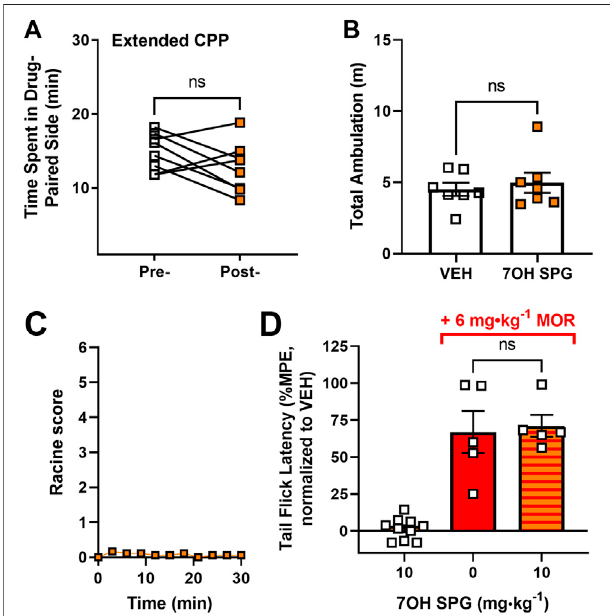
FIGURE7| Sideeffect pro fi le of10mg · kg ⁻ 1 7-hydroxyspeciogynine. (A) In a 10-day conditioned place preference (CPP) paradigm, the rewarding effects of 7-hydroxyspeciogynine (s.c.) were evaluated in male, WT mice ( n (cid:2) 8). (B) Locomotor data were extracted from the CPP experiment in (A) and averaged across all vehicle/ drug treatment days ( n (cid:2) 7). (C) The highest Racine score collected every 3 min for 30 min following administration of 7-hydroxyspeciogynine was evaluated for 30 min after drug administration ( n (cid:2) 9). (D) 7-hydroxyspeciogynine was tested for agonist and analgesic properties in male mice via the tail fl ick thermal nociception assay ( n (cid:2) 10). In the same paradigm, antagonistic effects were evaluated after administering 7-hydroxypeciogynine, followed by morphine (6 mg · kg ⁻ 1 , s.c.) 10 min later ( n (cid:2) 6), and were compared to vehicle plus morphine administration ( n (cid:2) 5) (for statistical details, see Supplemental Tables S2 – S5 ).